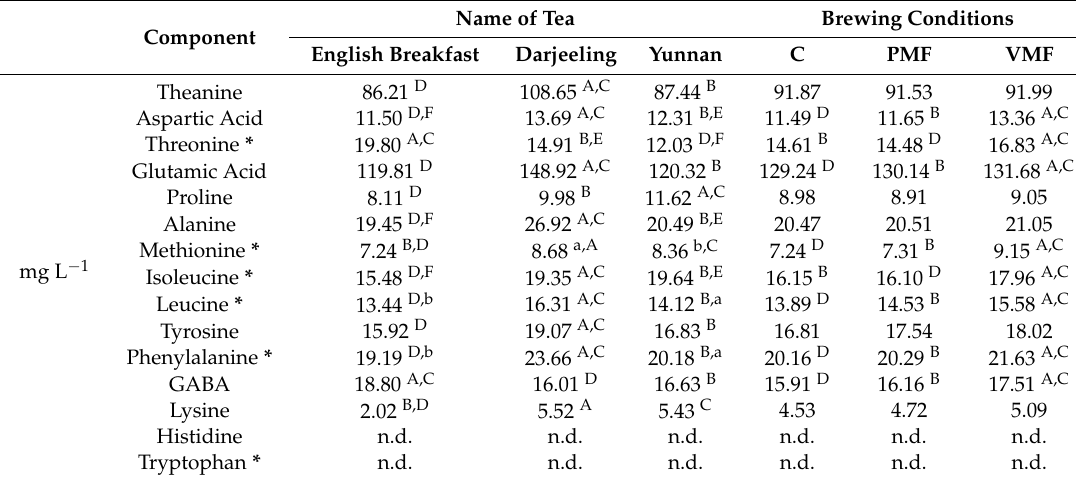
Table 3. Impact of the type of tea and manner of brewing on the content of amino acids in infusions of high-quality black